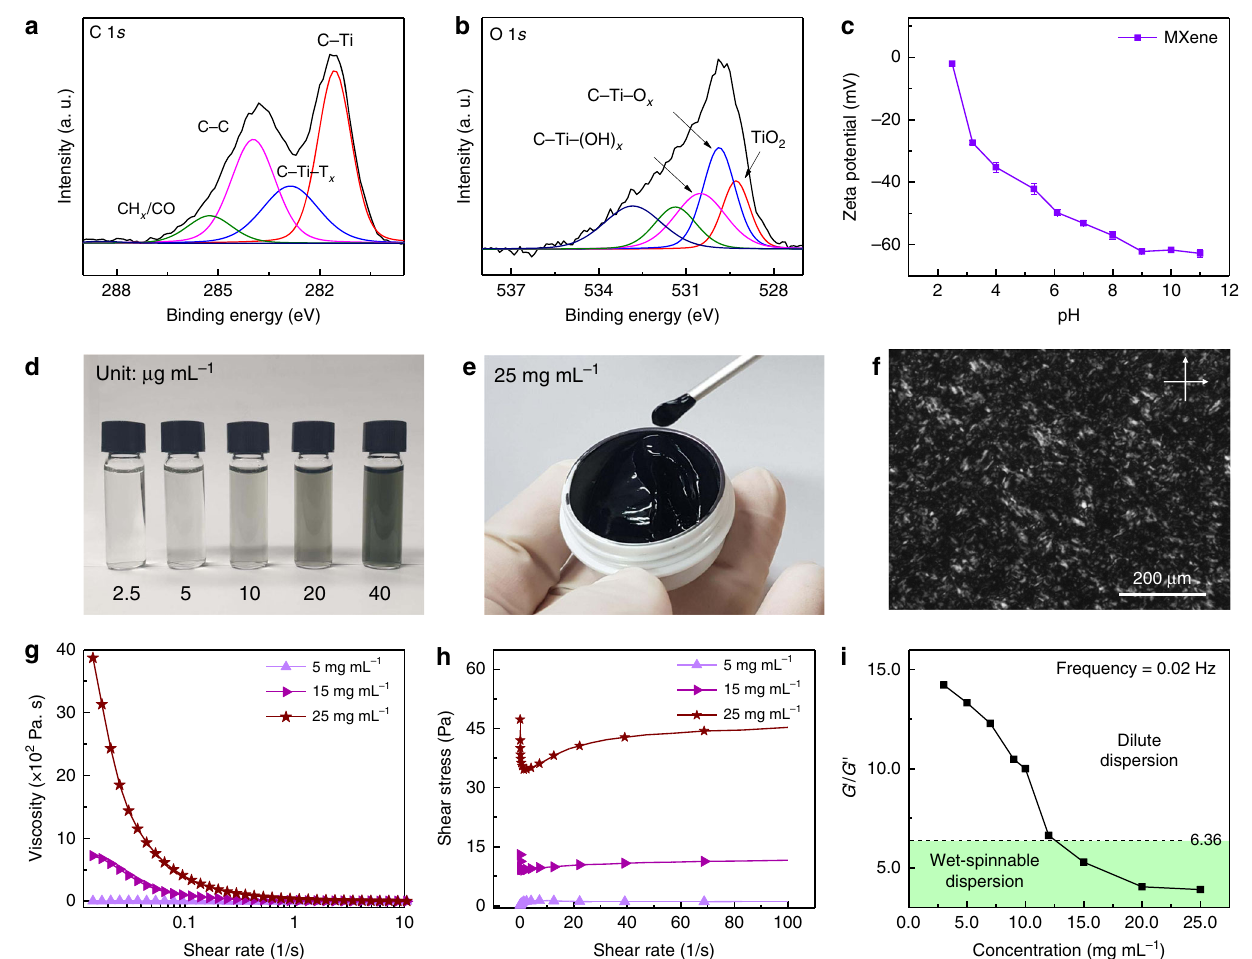
Fig. 3 Dispersibility and spinnability of MXene nanosheets in liquid-crystalline dispersion. a C 1 s and b O 1 s XPS spectra of MXene obtained from the dispersion. c Zeta potential of the MXene as a function of pH in the aqueous dispersions at a concentration of ~0.05 mg mL − 1 . d Optical image of diluted MXene dispersions with concentrations of 0.0025, 0.005, 0.01, 0.02, and 0.04 mg mL − 1 at 755 nm. e Optical image of the concentrated MXene LC dispersion (25 mg mL − 1 ). f POM image of the MXene dispersion (20 mg mL − 1 ) that exhibited optical birefringence. g Steady shear rheological properties of the MXene LC dispersions with various concentrations (1 – 25 mg mL − 1 ). h Shear stress of the MXene dispersion as a function of shear rate. i G ′ / G ″ ratio of the MXene dispersion as a function of concentration. The green region under G ′ / G ″ = 6.36 indicates the region for the wet-spinning of the MXene dispersion at a speci fi c shear rate (0.02